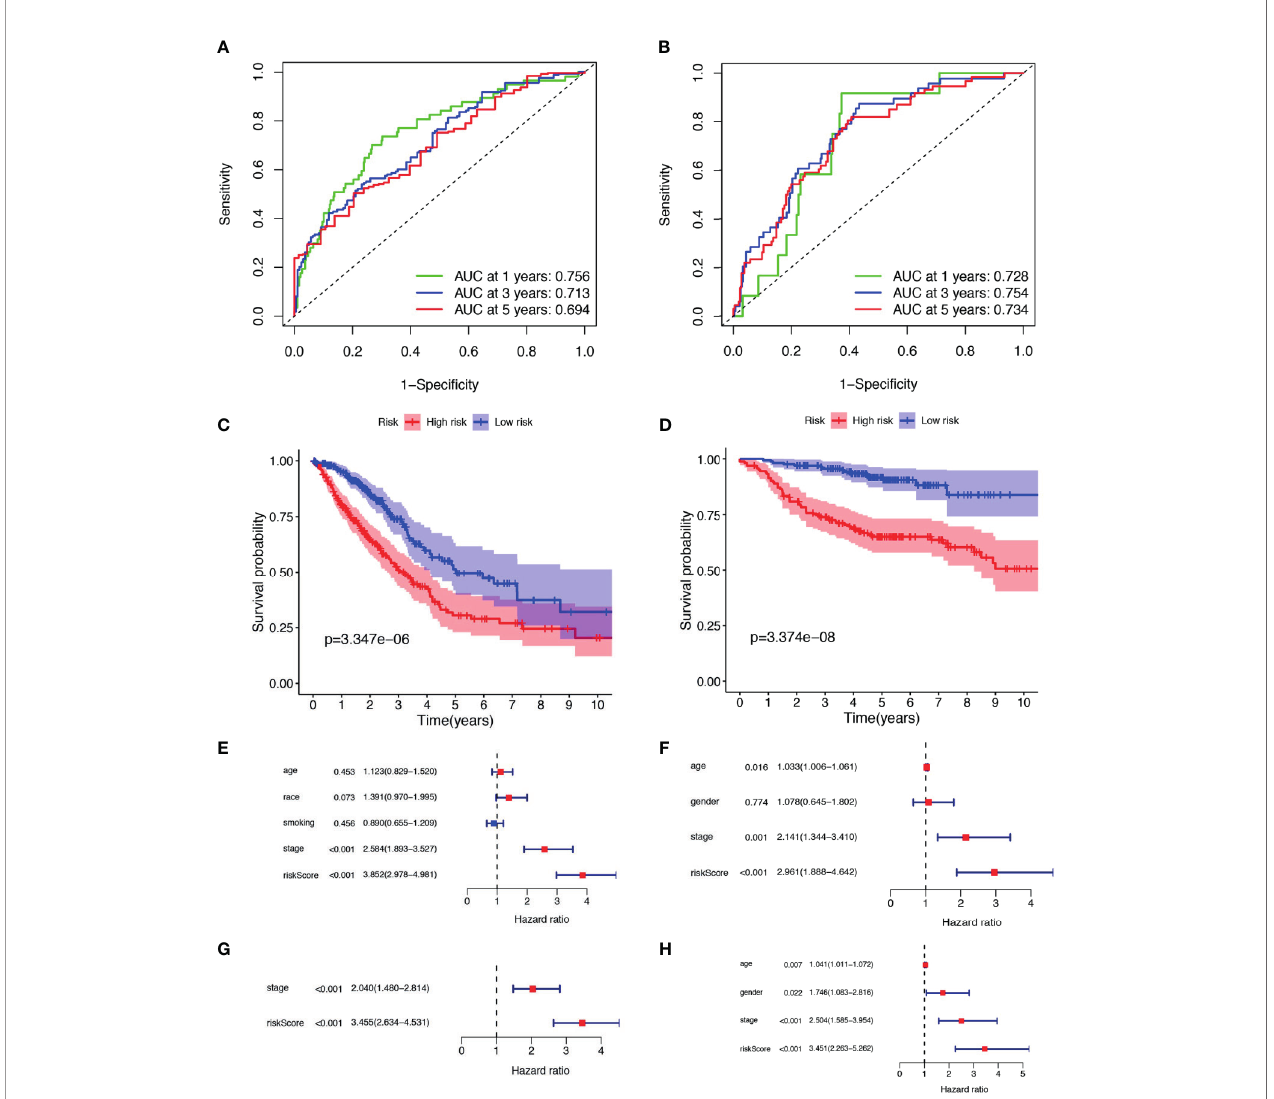
FIGURE 2 | Prognostic analysis of the risk score in the TCGA and three GEO cohorts. (A, B) Time-dependent receiver operating characteristic curves assess the prognostic performance of the risk score in TCGA and three GEO cohorts respectively. (C, D) Kaplan-Meier curves display the overall survival of patients in the high- and low-risk group in TCGA and three GEO cohorts respectively. (E, F) The univariate Cox regression analysis of the associations between the risk scores and clinical parameters and the overall survival (OS) of patients in TCGA and three GEO cohort. (G, H) The multivariate Cox regression analysis of the associations between the risk scores and clinical parameters and the OS of patients in TCGA and three GEO